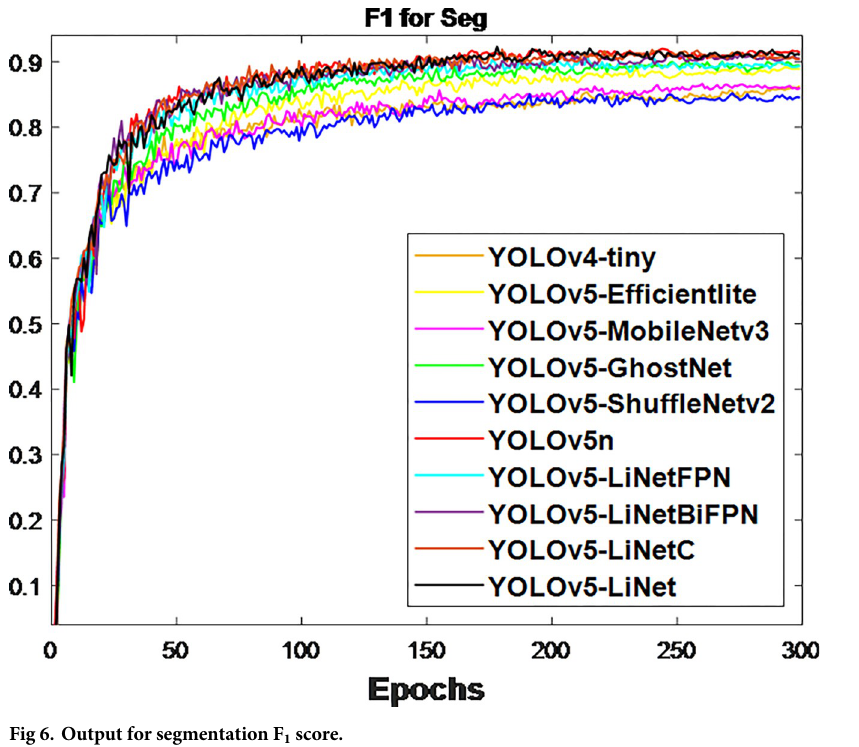
Fig 6. Output for segmentation F 1 score.